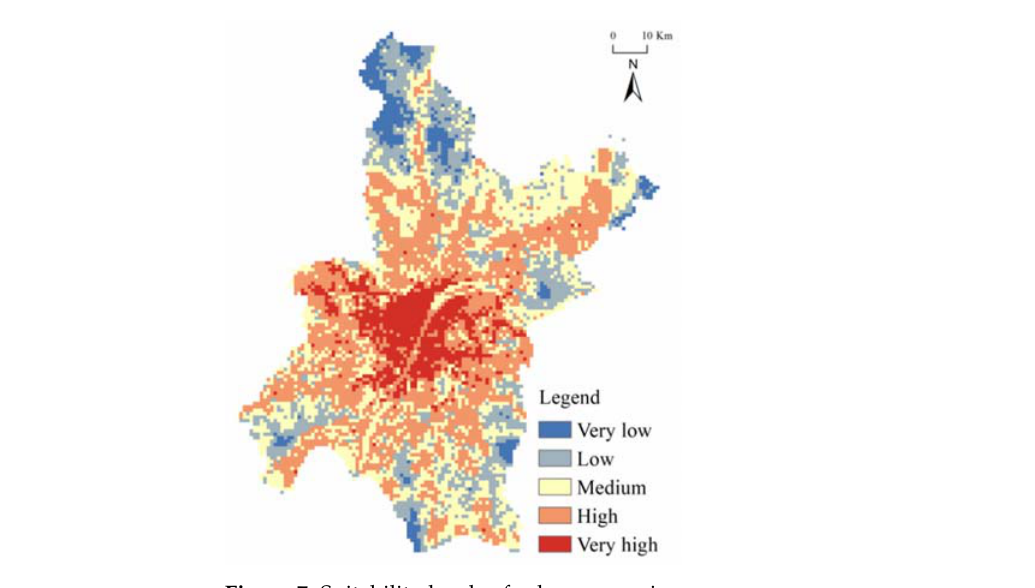
Figure 7. Suitability levels of urban expansion.